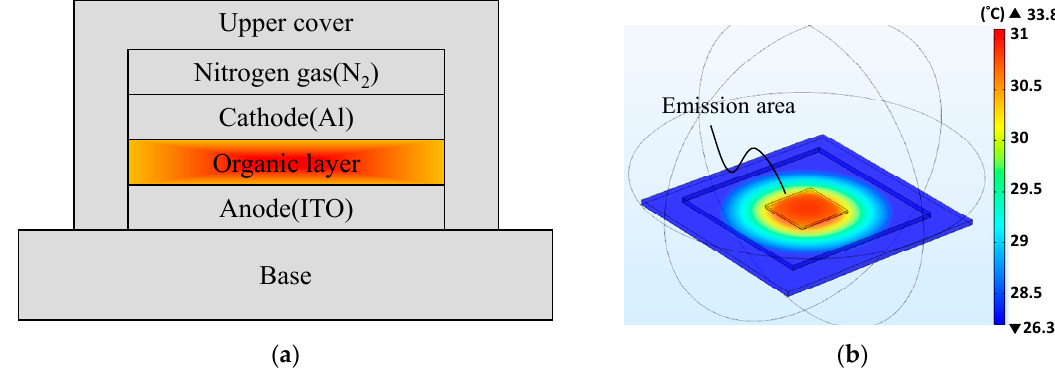
Figure 9. Another embodiment of the OLED with a desiccative layer filled with N 2 . (a) Schematic representation of structure, and (b) simulated temperature distributions on the upper cover glass.